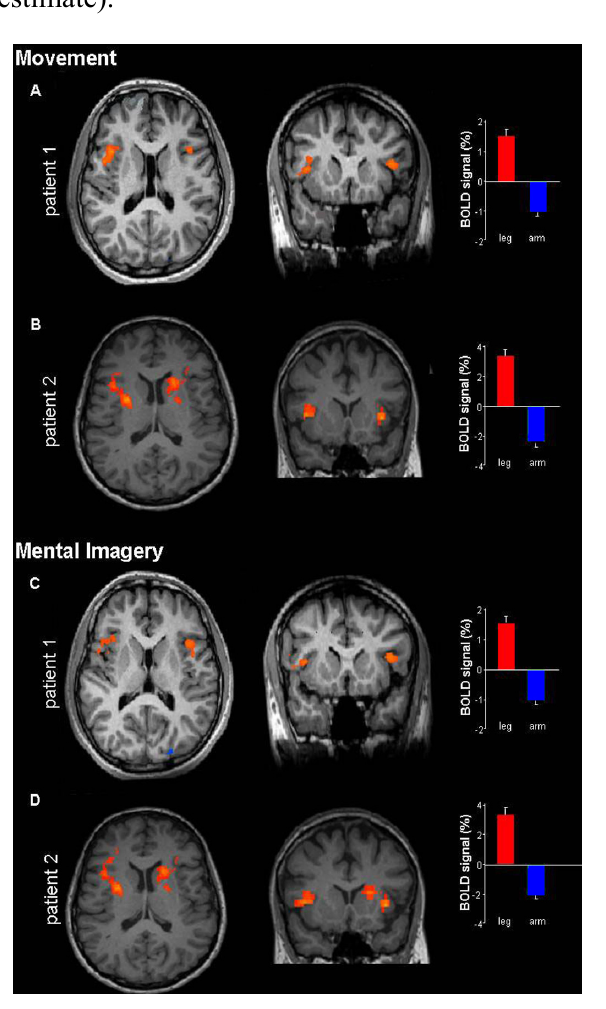
Figure 1. BOLD responses in the insular cortex during movement and mental-imagery conditions. Significant BOLD responses are superimposed on axial and coronal slices in the movement ( A , B ) and mental imagery ( C , D ) conditions for both patients. Percent signal change are shown on the right (leg: red; arm: blue). Note the similar patterns for the two patients as well as between movement and mental imagery conditions (error bars represent the standard error of